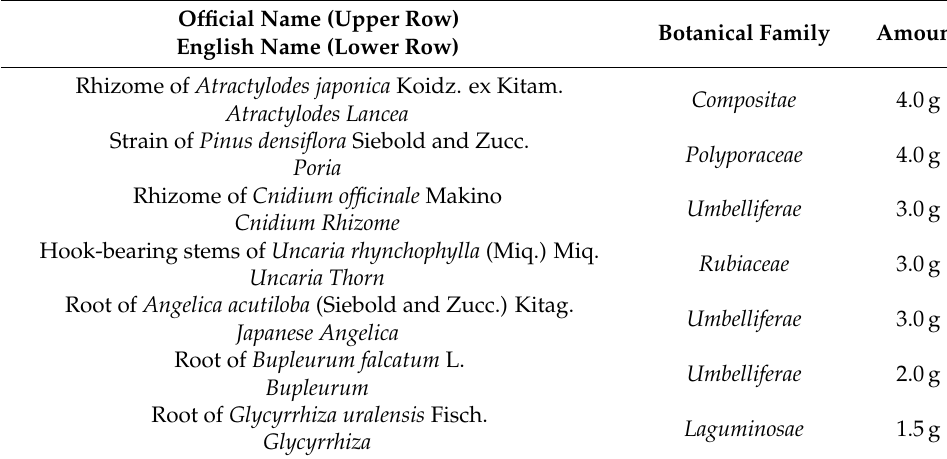
Table 1. The component galenicals of Yokukansan